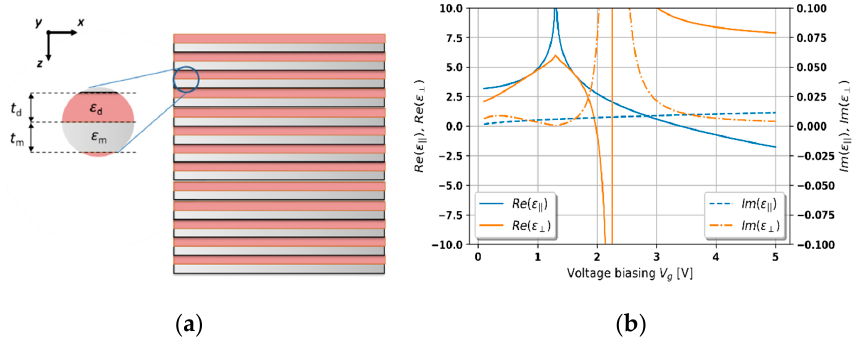
Figure 2. Schematic of the considered HMM medium ( a ) and effective permittivity components of the considered HMM medium vs. voltage biasing for wavelength λ 0 = 1550 nm ( b ).